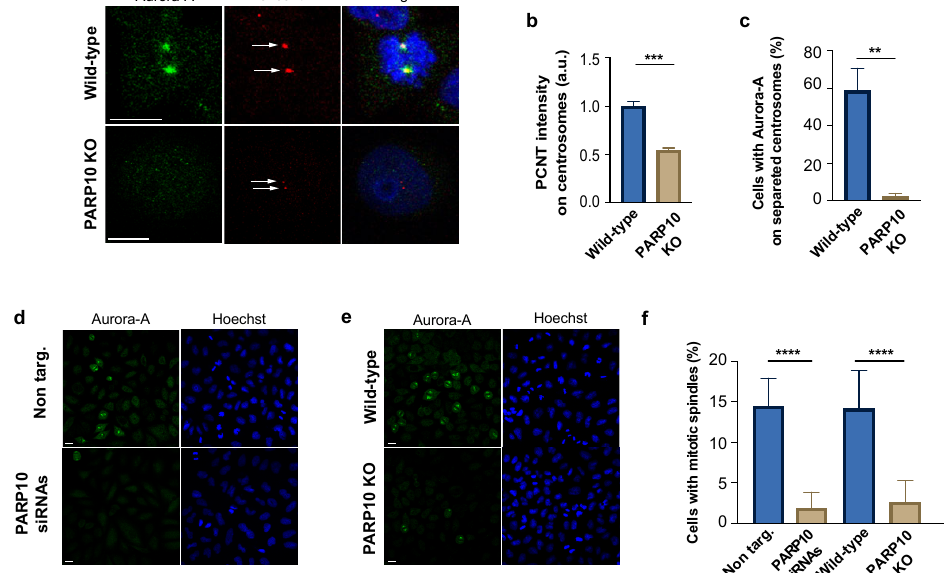
Figure 4. PARP10 favors Aurora-A centrosomal recruitment. ( a ) Representative images of synchronized wild-type and PARP10 KO HeLa cells fixed 10 h after thymidine release and processed for immunofluorescence using Aurora-A (green) and pericentrin (red) antibodies. Arrows indicate duplicated centrosomes. ( b ) Measurements of the fluorescence intensity of pericentrin recruited on centrosomes (A.U.). ( c ) Quantification of the percentage of cells positive for Aurora-A staining on separated centrosomes. ( d , e ) Representative microscopy confocal images of HeLa cells KO for PARP10 or treated with PARP10 siRNAs (48 h) and their respective controls processed for immunofluorescence using Aurora-A (green). ( f ) Quantification of the percentage of cells showing Aurora-A positive mitotic spindles. Data are means ( ± S.D.) from three independent experiments. Nuclei were labelled with Hoechst staining. Two-tailed Student’s t -tests were applied to the data (** p < 0.01; *** p < 0.001; **** p < 0.0001). Scale bars, 10 μ m.